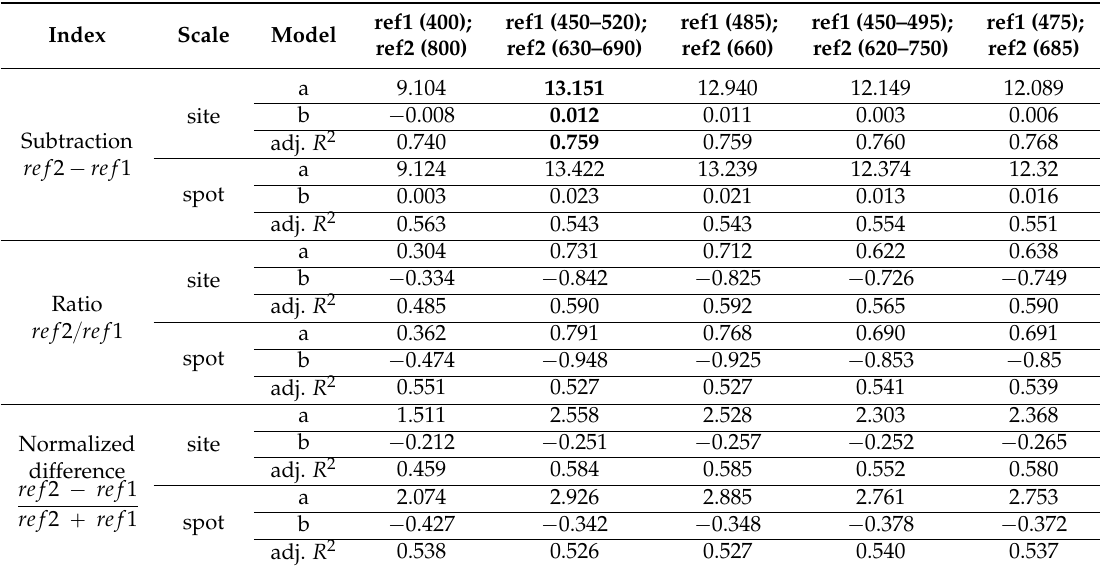
Table A2. Regression models for the oxidation indices.